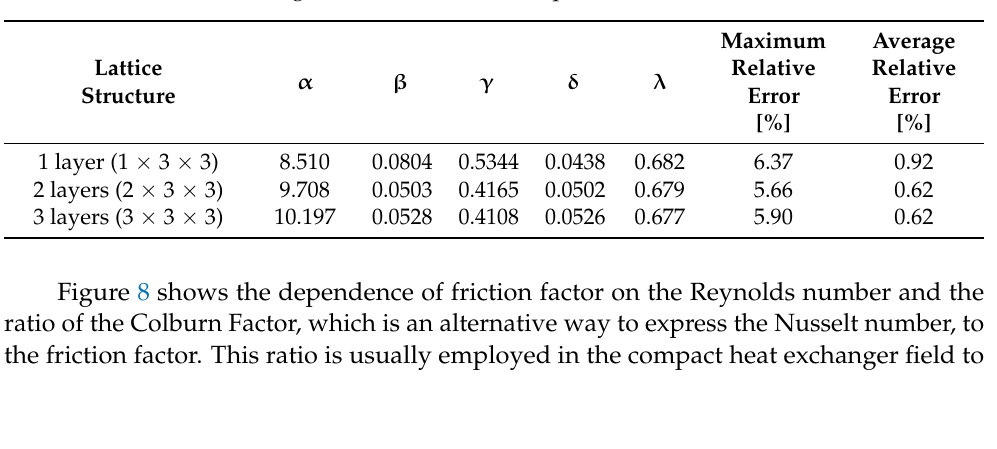
Table 5. Coefficients of the regression curve found in Equation